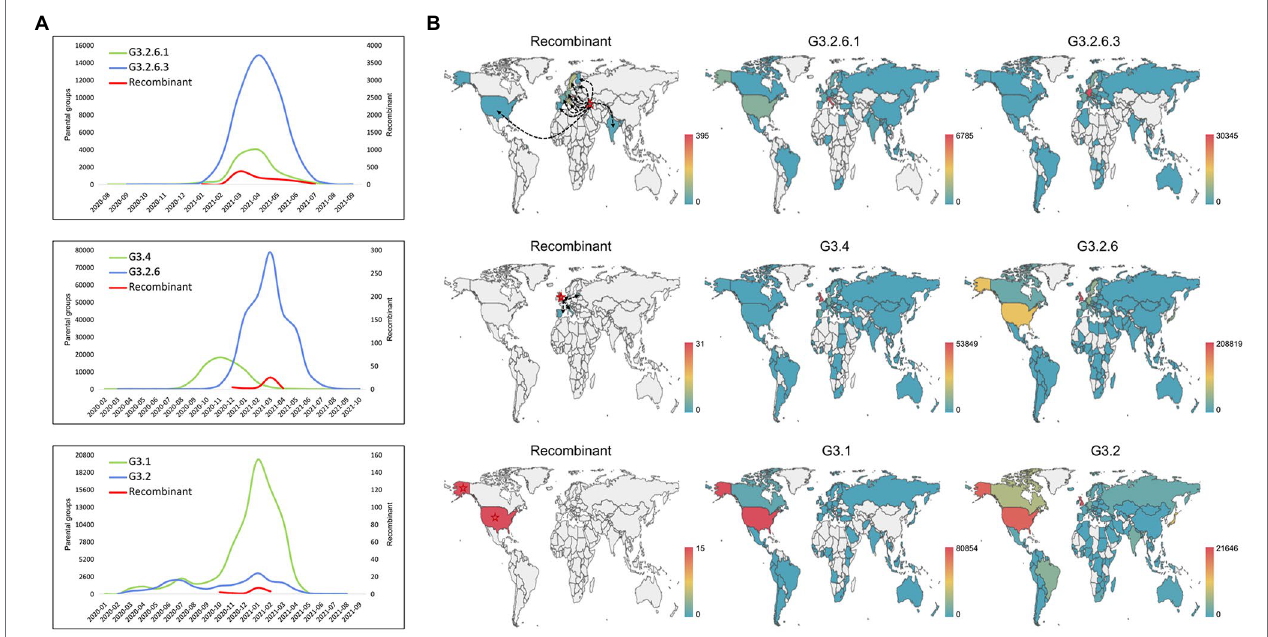
FIGURE 4 | Spatio-temporal distribution of the recombinants and their parental groups. (A) The temporal distribution of the recombinant and its parents. Three representative recombination types are shown: G3.2.6.1 and G3.2.6.3, G3.4 and G3.2.6, and G3.1 and G3.2. (B) The spatial distribution of the recombinant and its parents. Three representative recombination types are shown: G3.2.6.1 and G3.2.6.3, G3.4 and G3.2.6, and G3.1 and G3.2. The red stars and the black dotted lines with arrows represent the country where the recombinant was collected for the first time, and the likely transmission direction of recombinants,